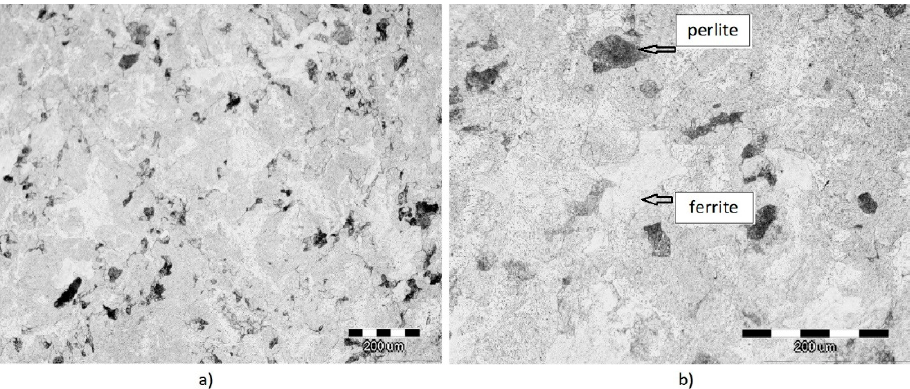
Figure 7. Microstructure of HTCS-130 hot work tool steel after etching in nital: ( a ) magnification